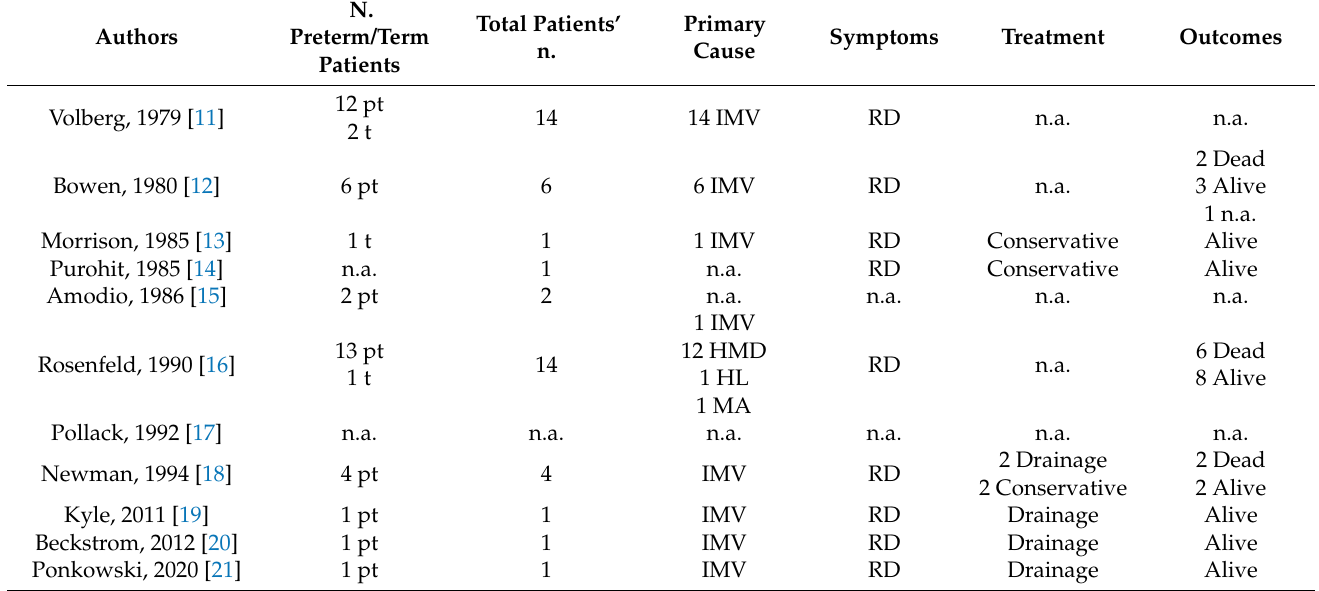
Table 1. Summary table of cases of retrocardiac pneumomediastinum in paediatric